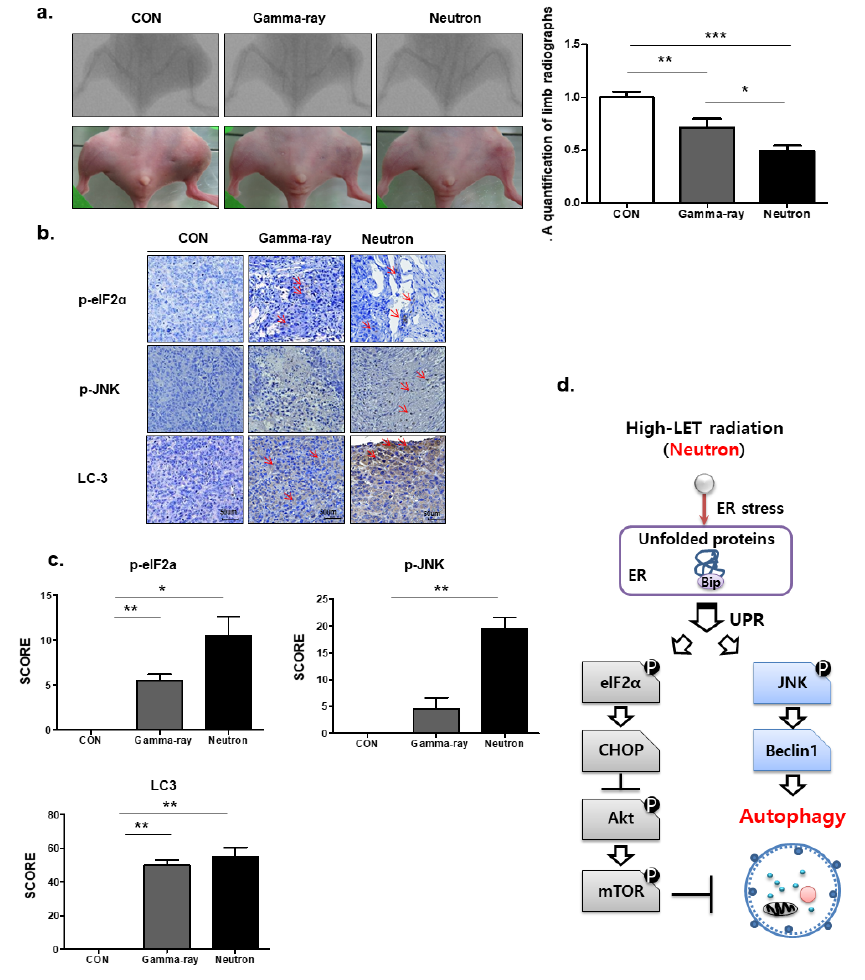
Figure 5. Autophagic e ff ects of neutron beams on orthotopic tumors in vivo. ( a ) KHOS / NP cells were injected into the proximal tibia of four groups each containing three nude mice to generate an orthotopic tumor model. The dimensions of the leg (including the tumor) were measured every 7 d by X-ray analysis. Representative radiographs of the limb of a mouse at 0 and 6 weeks after tumor inoculation are shown. Representative images of animal tumors at 6 weeks and a graph of tumor size against time are shown. ( b , c ) p-elF2, p-JNK, and LC3 expression in xenografts was examined by immunohistochemistry. Representative images are shown. Values represent the means ± SD (n = 3); * p < 0.05, ** p < 0.01. ( d ) The proposed signaling pathways involved in the autophagic cell death by neutrons in OS